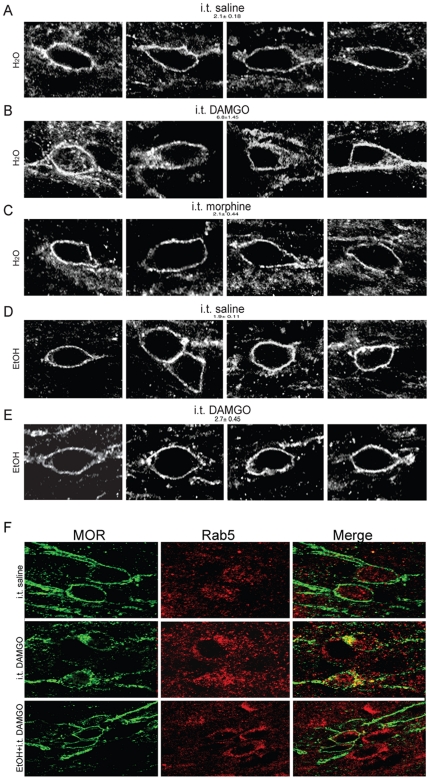
MOR distribution in lamina II neurons of the spinal cord after 8 weeks of drinking.(A–E) Distribution of the MOR. MORs were primarily localized to the plasma membrane of neurons after injection of saline in rats drinking either water (A) or ethanol (D). DAMGO (B), but not morphine (C), promoted endocytosis of the MOR in water drinking rats. (E) DAMGO did not promote endocytosis of MOR in ethanol drinking rats. The numbers over each panel represent the average number of intracellular vesicles per neuron (n>-90 neurons per group, 2–5 rats per group) p<0.001: i.t. DAMGO vs. all other groups (see Methods). (F) Co-immunostaining of MOR (green) and Rab5 (red) in water or ethanol drinking rats. MOR was co-localized with Rab5 after DAMGO treatment in water drinking rats, but not in ethanol drinking rats.